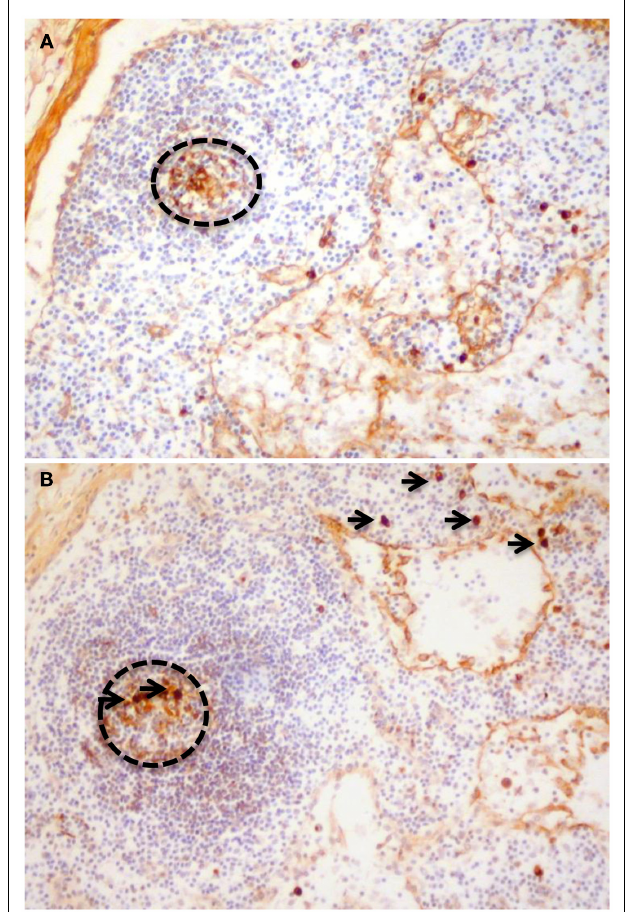
FIGURE 2 | Paraffin sections stained to detect (A) IgA1 and (B) IgA2. Cells with cytoplasmic immunoglobulin of both subclasses can be observed in germinal centers (dotted circles) demonstrating that the mesenteric nodes could be classified as a non-GALT site of induction for IgA responses.The presence of cells with cytoplasmic IgA2 in mesenteric nodes (arrows) also demonstrates that switching to IgA2 is not only a feature of terminal differentiation in the colonic lamina